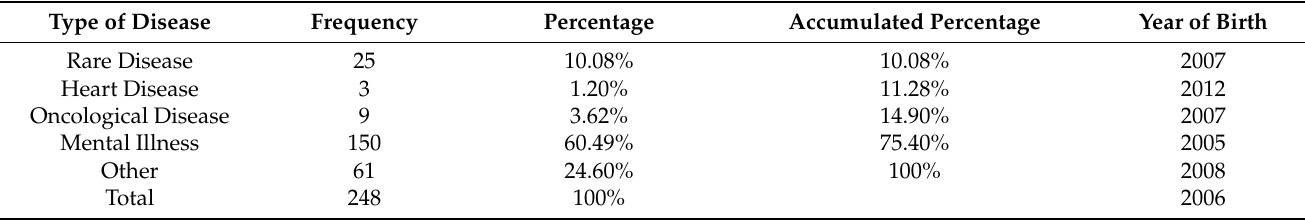
Table 1. Descriptive table according to type of